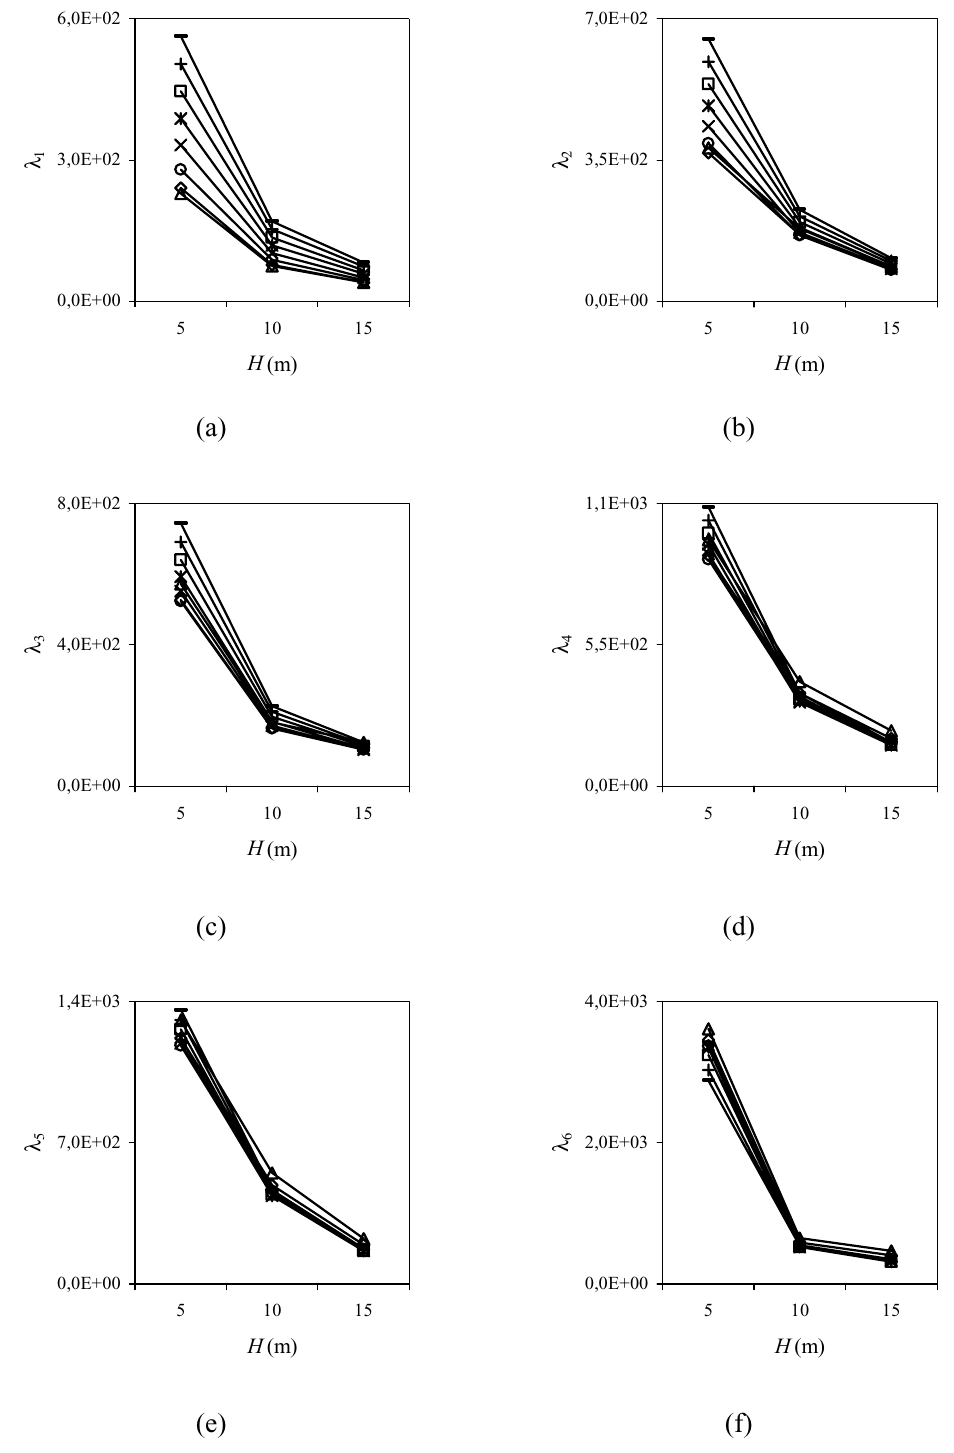
Fig. 7. The effect of different value of H and γ on the first six frequency parameters of the plate on elastic foundation for H/l y = 1.000. – ∆ –, γ = 1; – ♦ –, γ = 2; –o–, γ = 3; – × –, γ = 4; –*–, γ = 5; – (cid:2) –, γ = 6; – + –, γ = 7; —, γ =